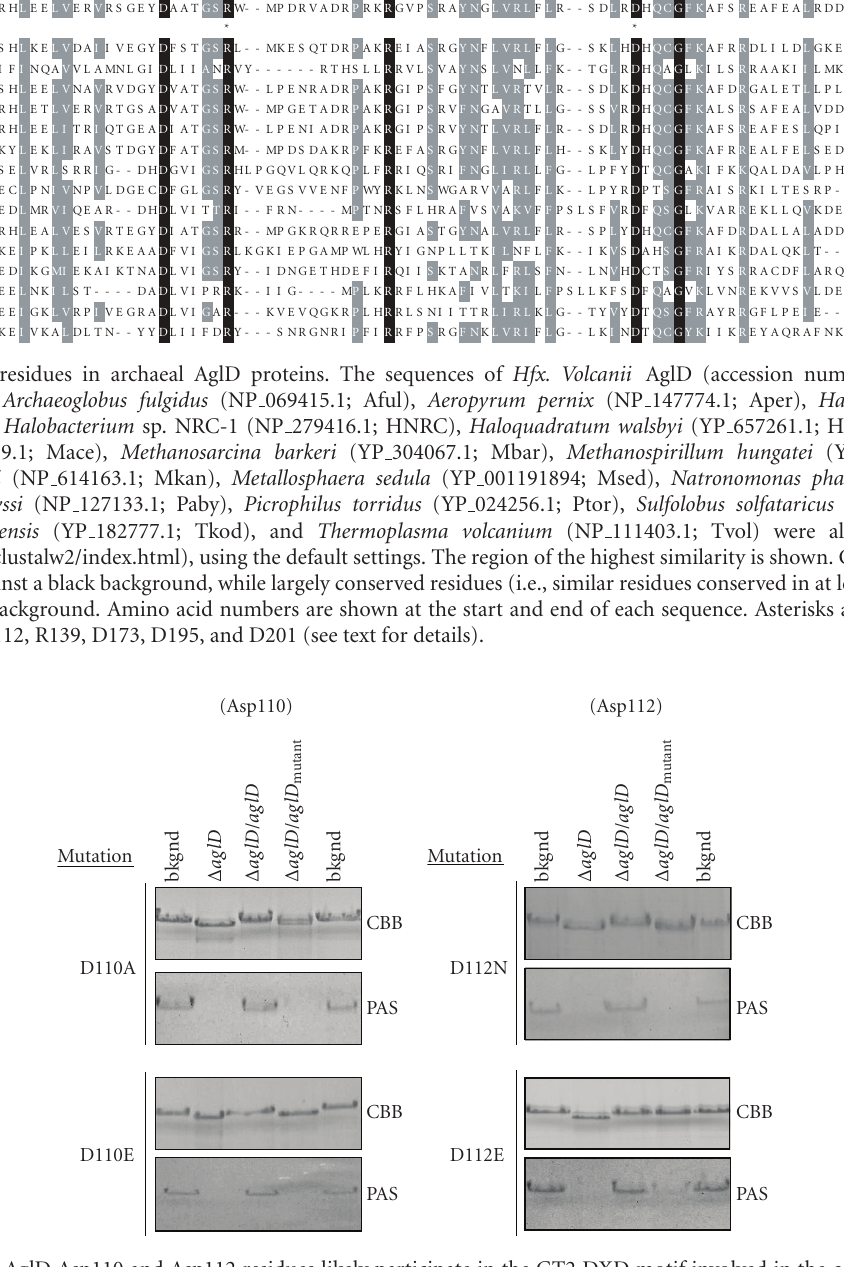
Figure 3: Hfx. volcanii AglD Asp110 and Asp112 residues likely participate in the GT2 DXD motif involved in the catalytic activity of the enzyme. Site-directed mutagenesis was performed to generate CBD-AglD containing mutations of Asp110 (left column) or Asp112 (right column), as listed on the left of each panel. For each mutant, the upper and lower panels, respectively, show the Coomassie- and PAS- stained S-layer glycoprotein from the background strain (lanes 1 and 5), from the aglD deletion strain (lane 2), from the aglD deletion strain complemented with a plasmid encoding CBD-AglD (lane 3), or from the aglD deletion strain complemented with a plasmid encoding CBD fused to mutated AglD (lane